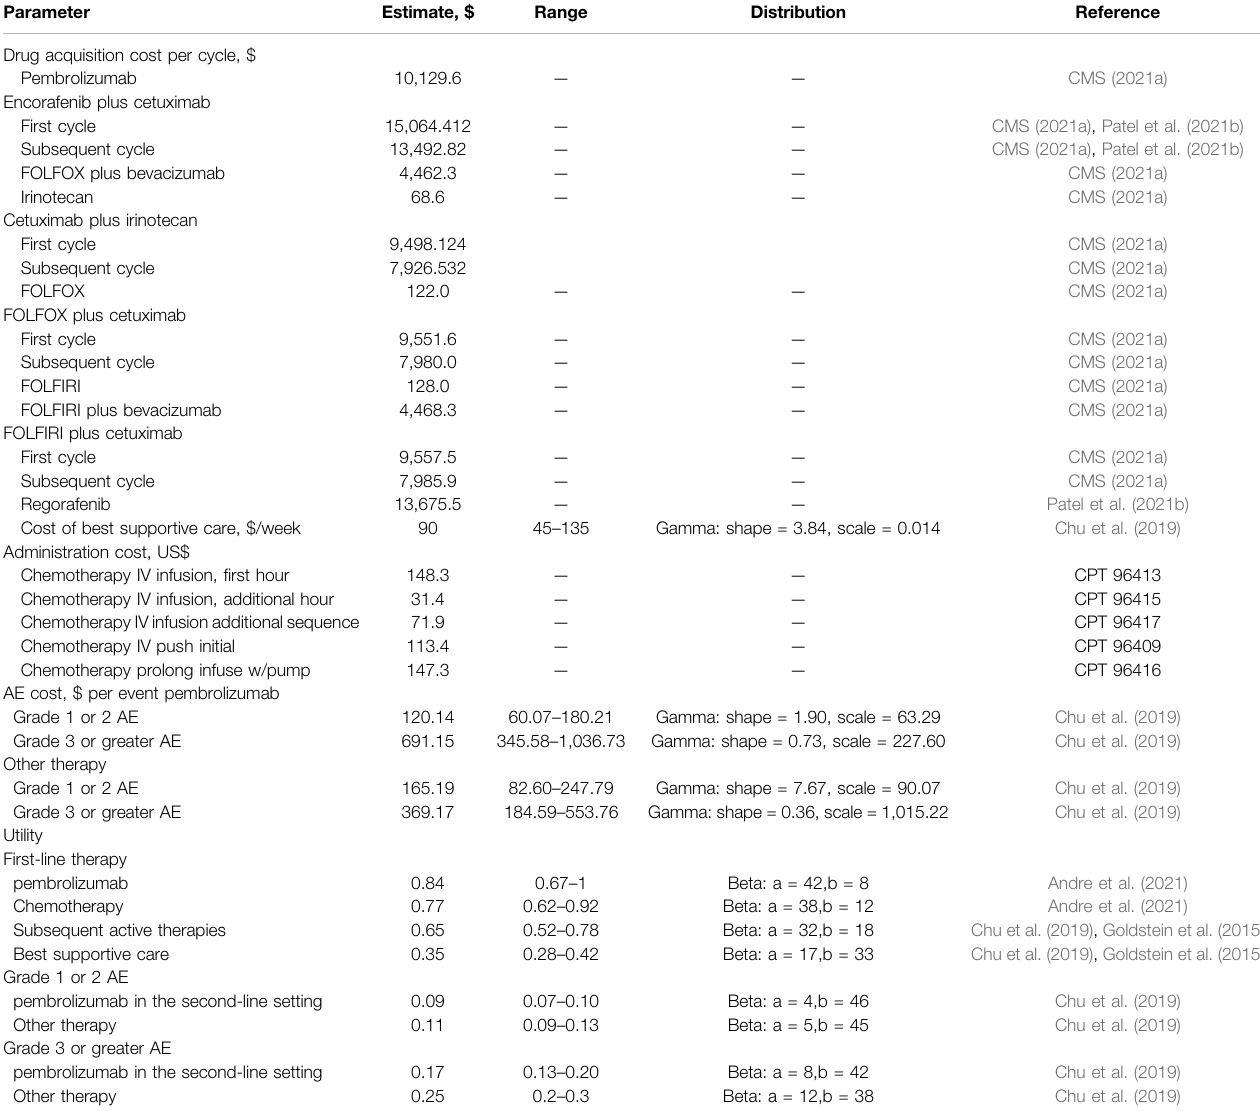
TABLE 2 | Model costs and utilities. Parameter Estimate,